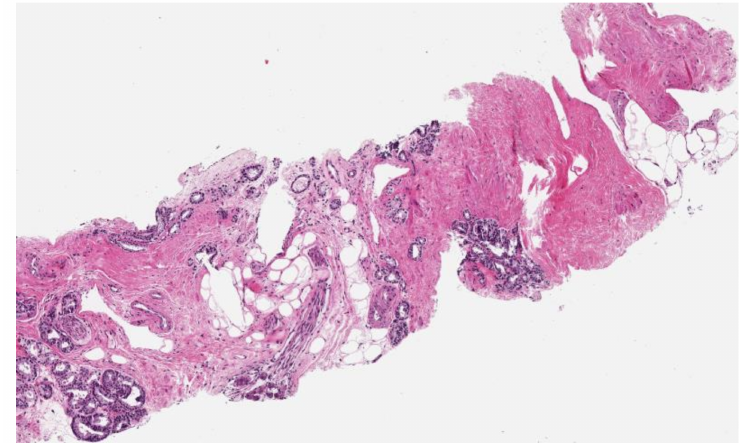
Figure 3. Prostate biopsy showing prostate acinar adenocarcinoma (Gleason score 3 + 4 = 7, grade group 2; percentage of Gleason pattern 4 equal to 40%; Gleason pattern 4 architecture fused glands). The tumor has spread to the periprostatic soft tissue composed by adipose and fibrous tissue and nerves. Fibrosis basically replaced the adipose tissue when infiltrated by cancer, i.e., stromal reaction. 10 ×